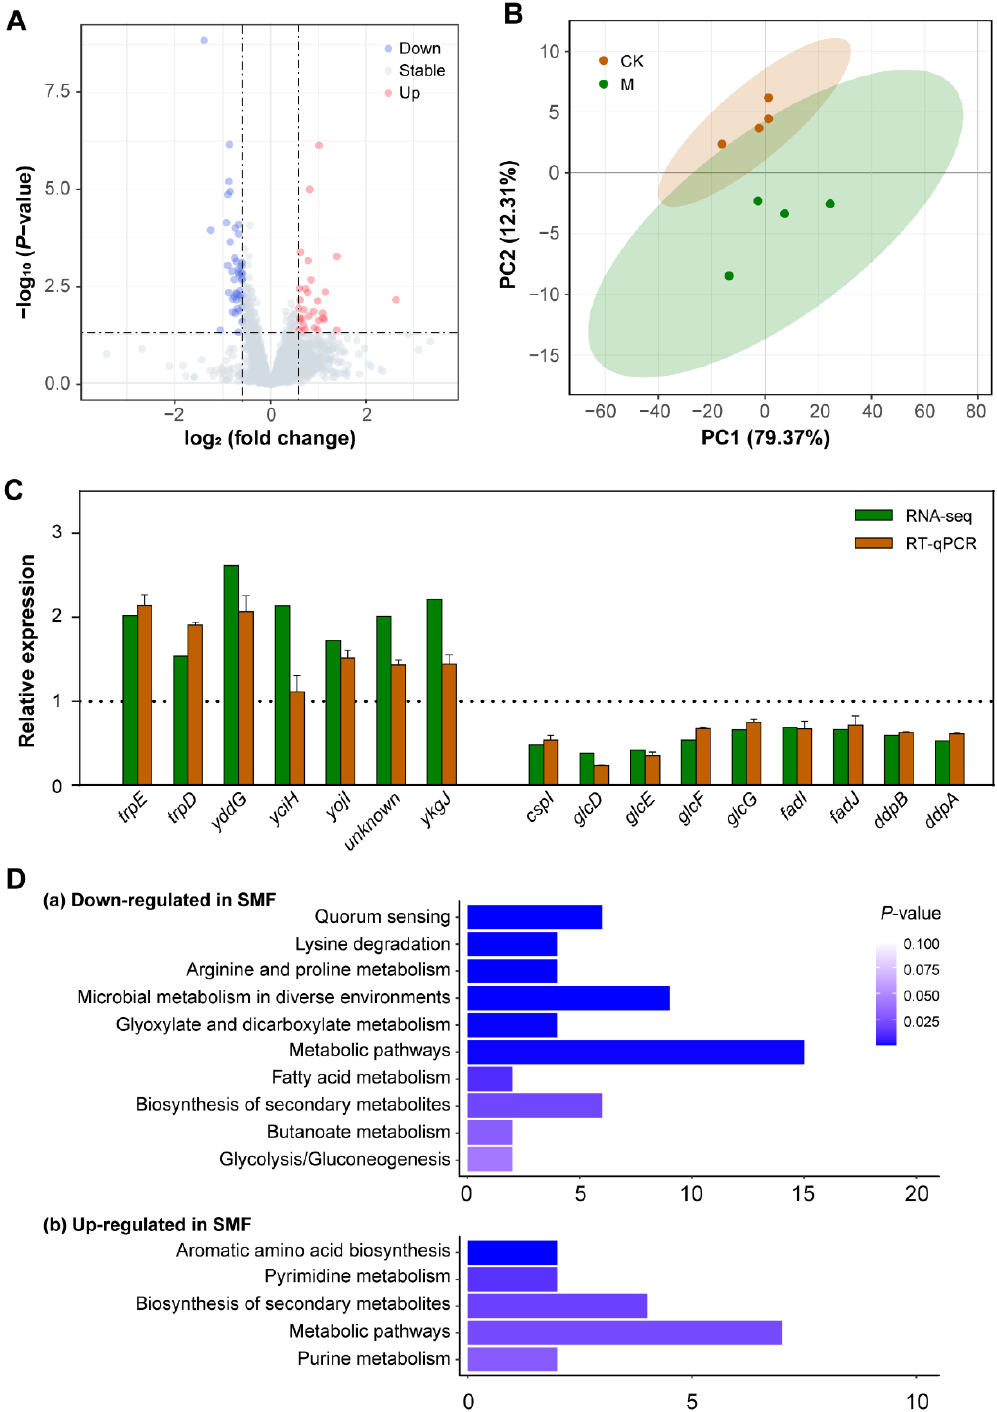
Figure 2. Transcriptomic analysis of 250 mT SMF effects on E. coli gene expression. ( A ) Volcano map of differentially expressed genes (DEGs) between SMF-treated and -untreated groups. Statistically upregulated and downregulated DEGs are shown as red or blue dots, respectively; the genes without significant difference in expression are shown as gray dots. ( B ) PCA analysis of the samples using transcriptomic data from four independent biological replicates. ( C ) Validation of RNA-Seq data by RT-qPCR. ( D ) KEGG analysis of SMF effects based on DEGs.